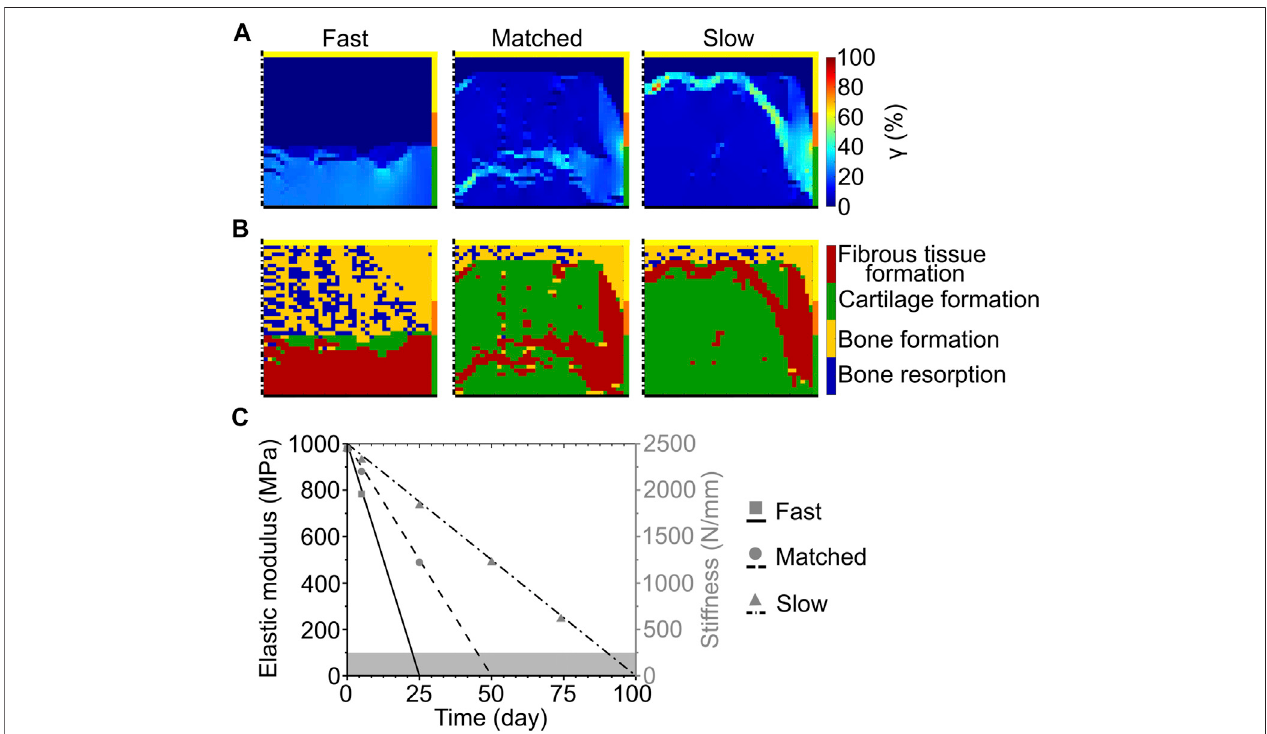
FIGURE 4 | In fl uence of scaffold degradation by bulk degradation on osteochondral defect repair. (A) Distribution of octahedral shear strain ( γ ); (B) prediction of tissue formation based on the mechanical stimulus ( S ). The left, middle, and right columns show the repair outcome with fast, matched and slow degradation speed, respectively, at day 125. The yellow, orange, and green borders indicate the neighboring healthy tissues of cancellous bone, subchondral bone, and cartilage, respectively. The dash-dot and solid black lines highlight the axis of symmetry and the articular surface, respectively; (C) Material elastic modulus and scaffold stiffness during degradation with different degradation speeds. The grey area marks the region of concomitant scaffold erosion. Lines and symbols refer to elastic modulus and stiffness,